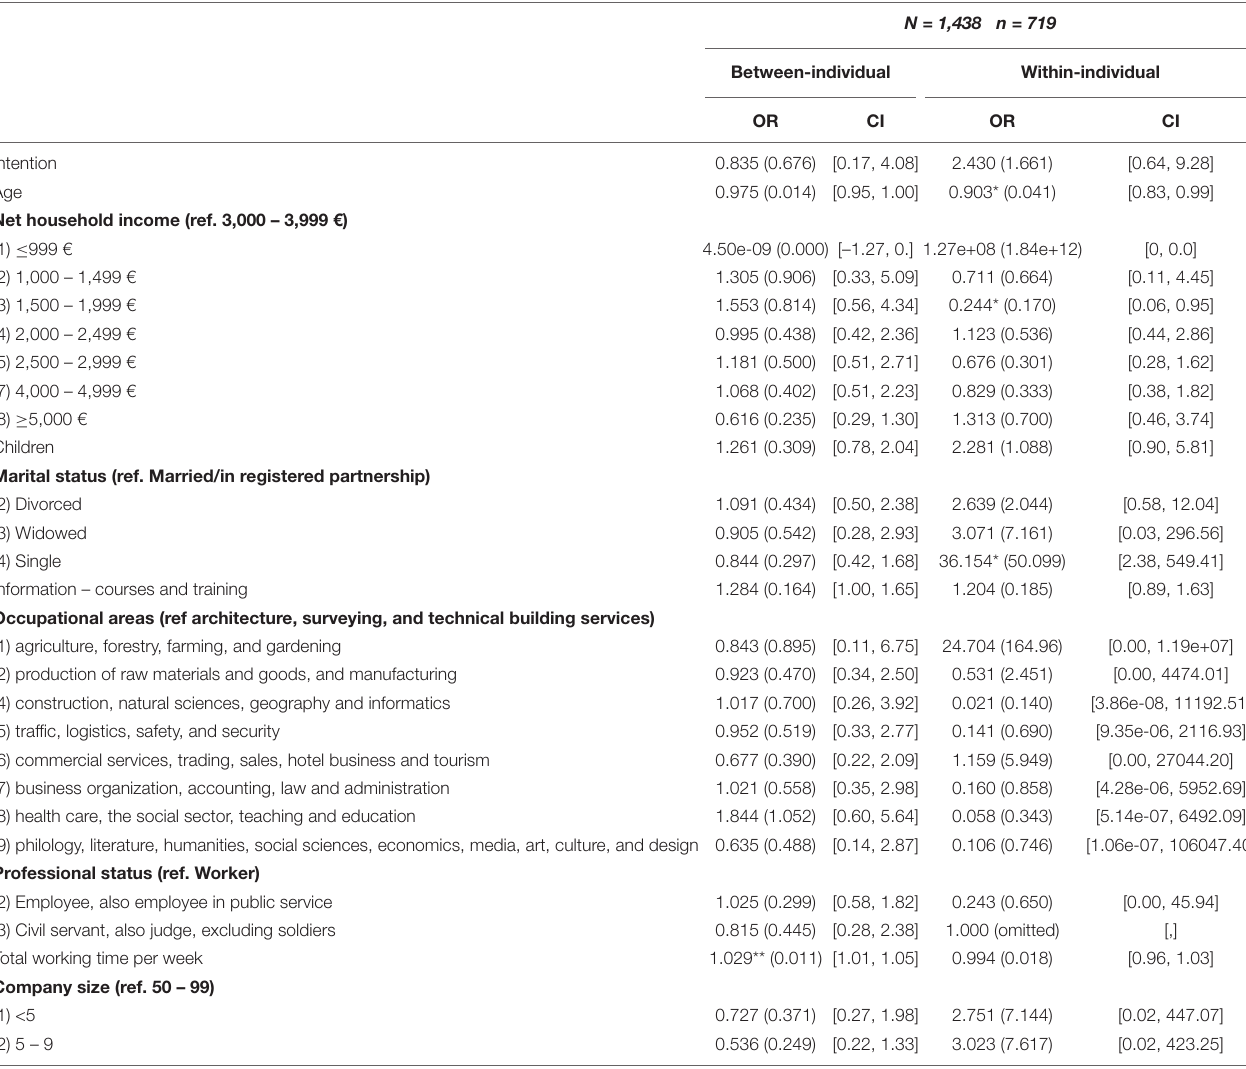
TABLE 5 | Results (Hypothesis 4 – subsample of individuals who were not offered a leave of